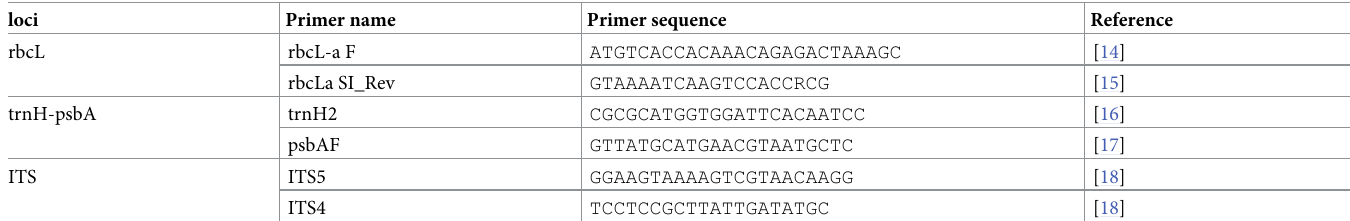
Table 2. Primers used in this